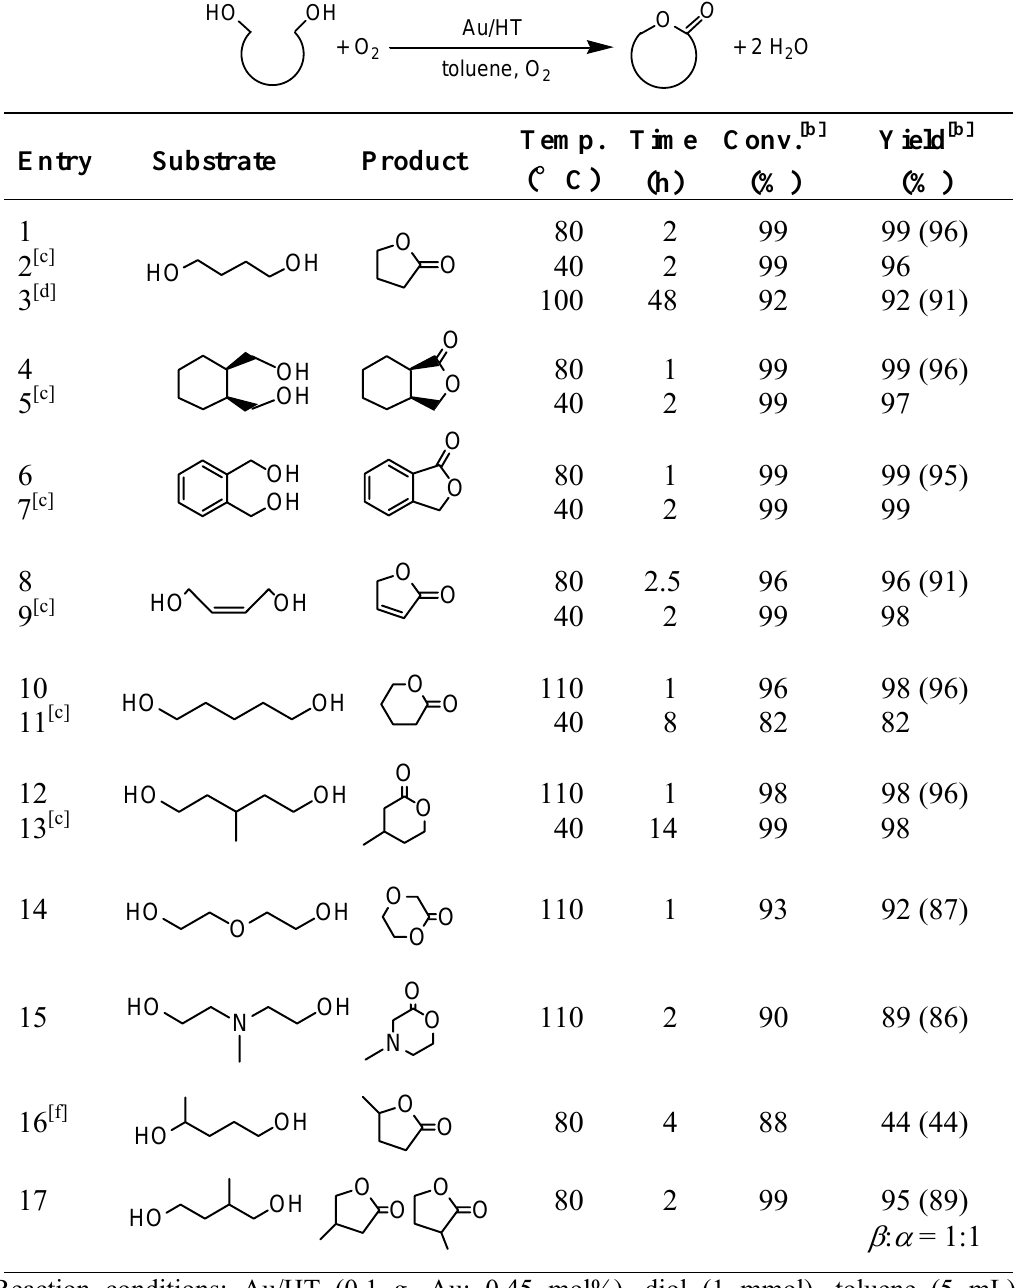
Table 3. Oxidation of Various α, ω -Diols Using Au/HT [a] .